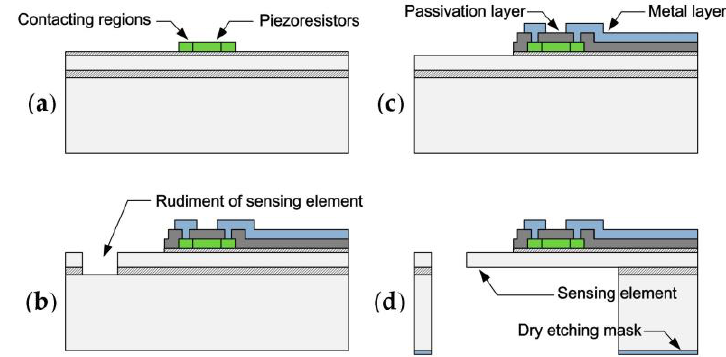
Figure 1. Fabrication process of the high-temperature MEMS surface fence. ( a ) The heavily doped polysilicon piezoresistors are fabricated. ( b ) The metal layers above the passivation layers are sputtered and patterned for better wire-bonding reliability at high temperature. ( c ) The rudiment of the sensing element is patterned by the ICP process. ( d ) Back-etching helps release the